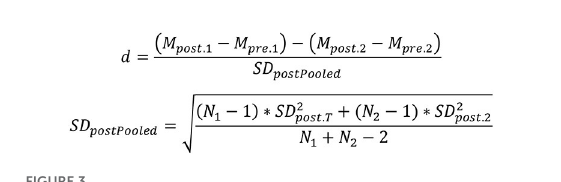
FIGURE3 Formula for calculating Cohen’s d for pretest-posttest control group design.